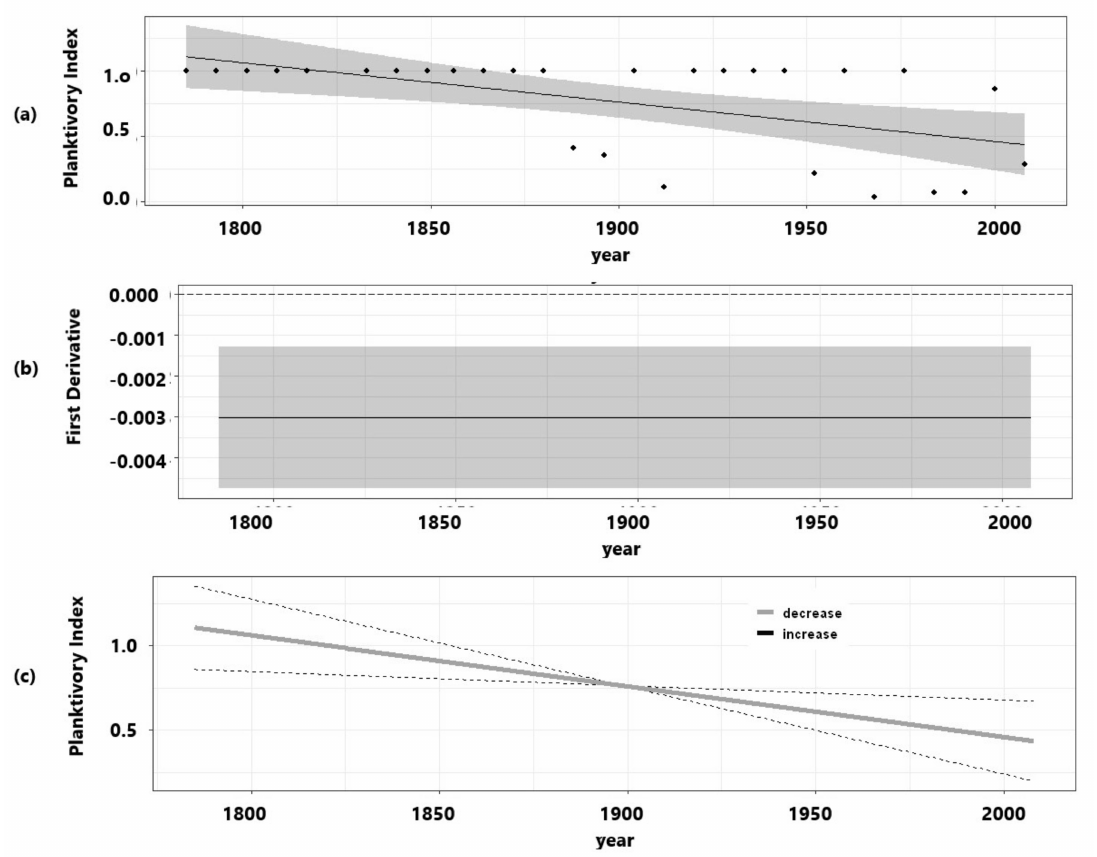
Figure 8. GAM fitted to the planktivory index ( Daphnia / ( Daphnia + Bosmina )) estimated from the ephippial assemblage in the sedimentary archive of Lake Blanca Chica. ( a ) Observed values, GAM-based trend fitted and its simultaneous interval; ( b ) estimated first derivative of the GAM fitted trend and the 95% simultaneous interval; ( c ) period of